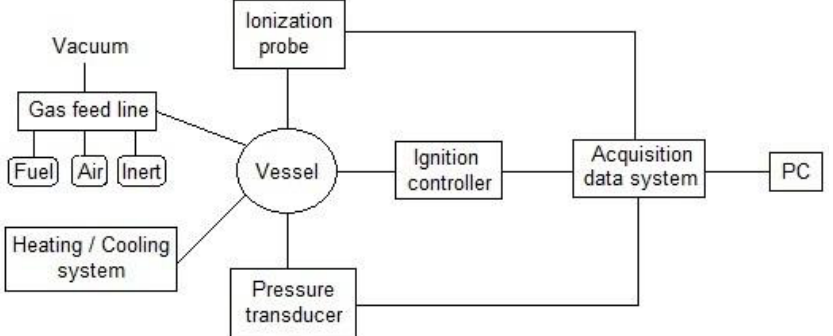
Figure 1. Schematic diagram of the test equipment.